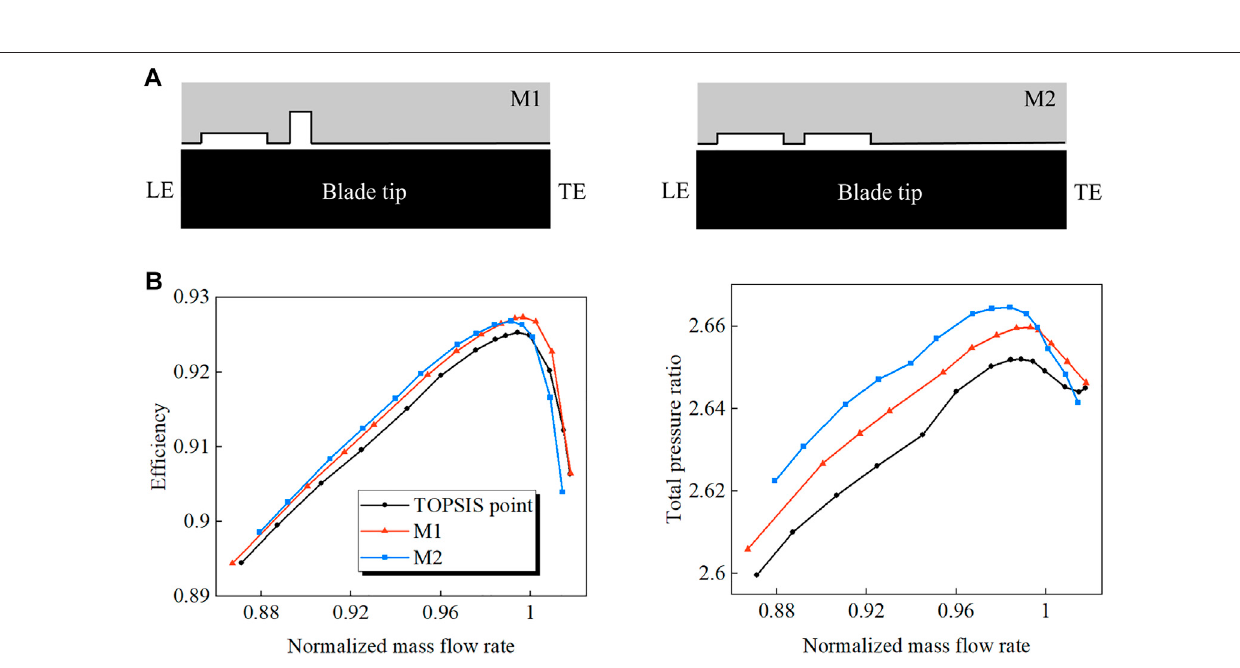
Frontiers in Energy Research |